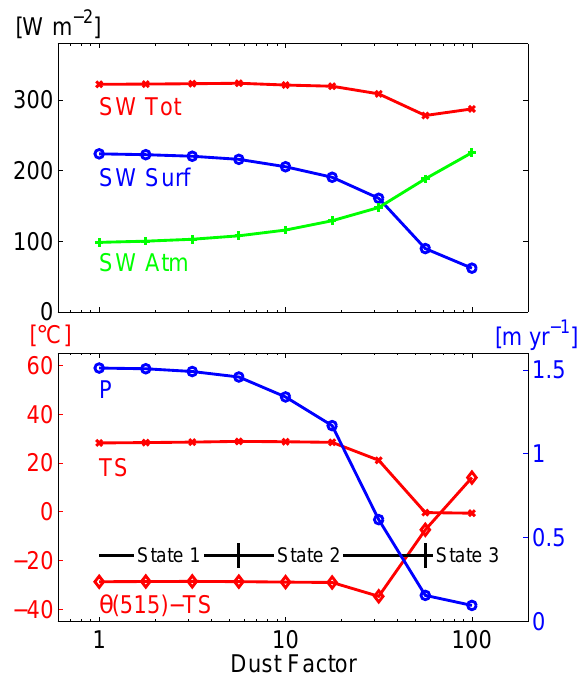
Fig. 1. Regimes in tropical stability and precipitation determined by atmospheric dust level. (top) The absorption of solar radiation by the surface (SW Surf), the atmosphere (SW Atm), and the sum of the surface and atmosphere (SW Tot) as a function of the factor by which current tropical dust levels are increased (dust factor). (bottom) The precipitation (P), tropical surface temperature (TS), and the difference between mid-tropospheric (515 mb) potential temperature and surface temperature ( θ (515)-TS) as a function of the dust factor. In State 1 convection maintains the marginal convective stability of the troposphere. In State 2 absorption of solar energy by midtropospheric dust partially replaces convection in maintaining marginal convective stability. In State 3 solar absorption by dust causes an inversion.